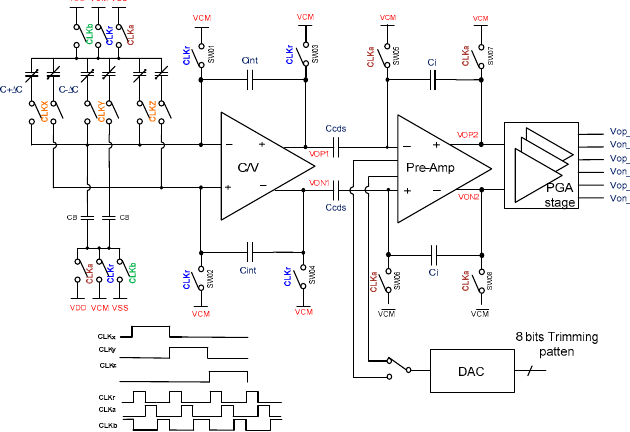
Figure 4. Schematic diagram of the switched-capacitor sensing circuit with trimming diagram.